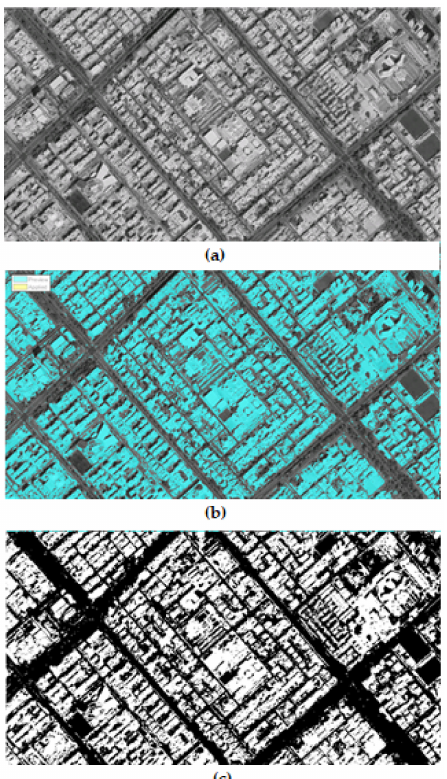
Figure 3. ( a ) Pre-processing, ( b ) threshold adaptation, and ( c ) post-processing images depicting the rooftop area of buildings in the sample